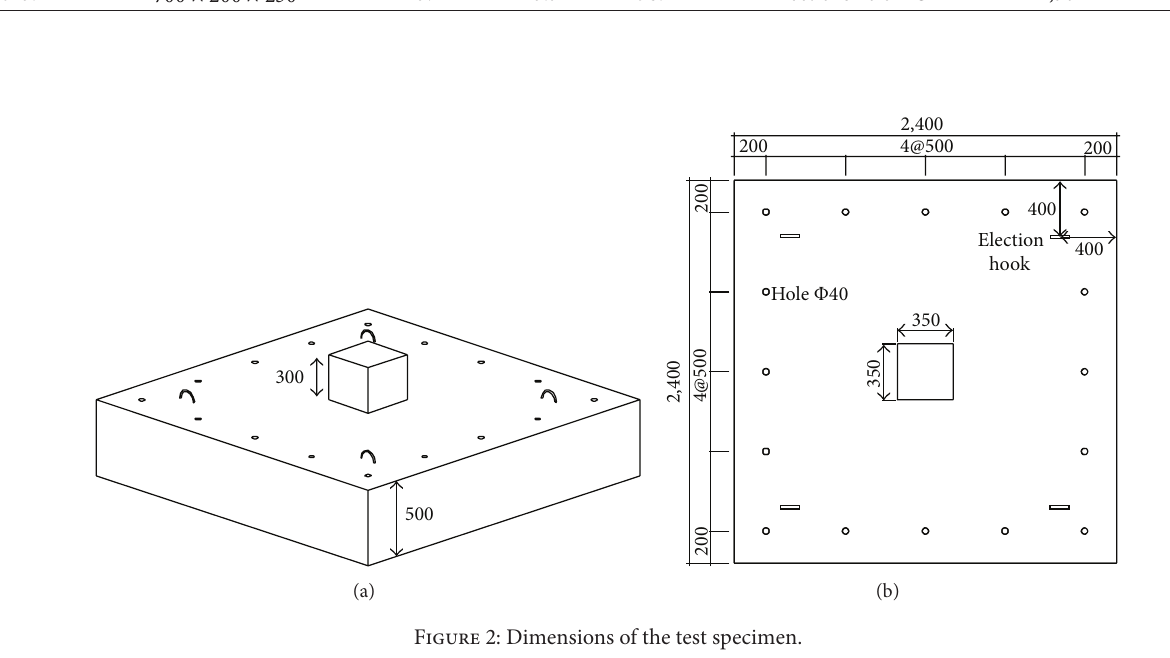
Figure 2: Dimensions of the test specimen.